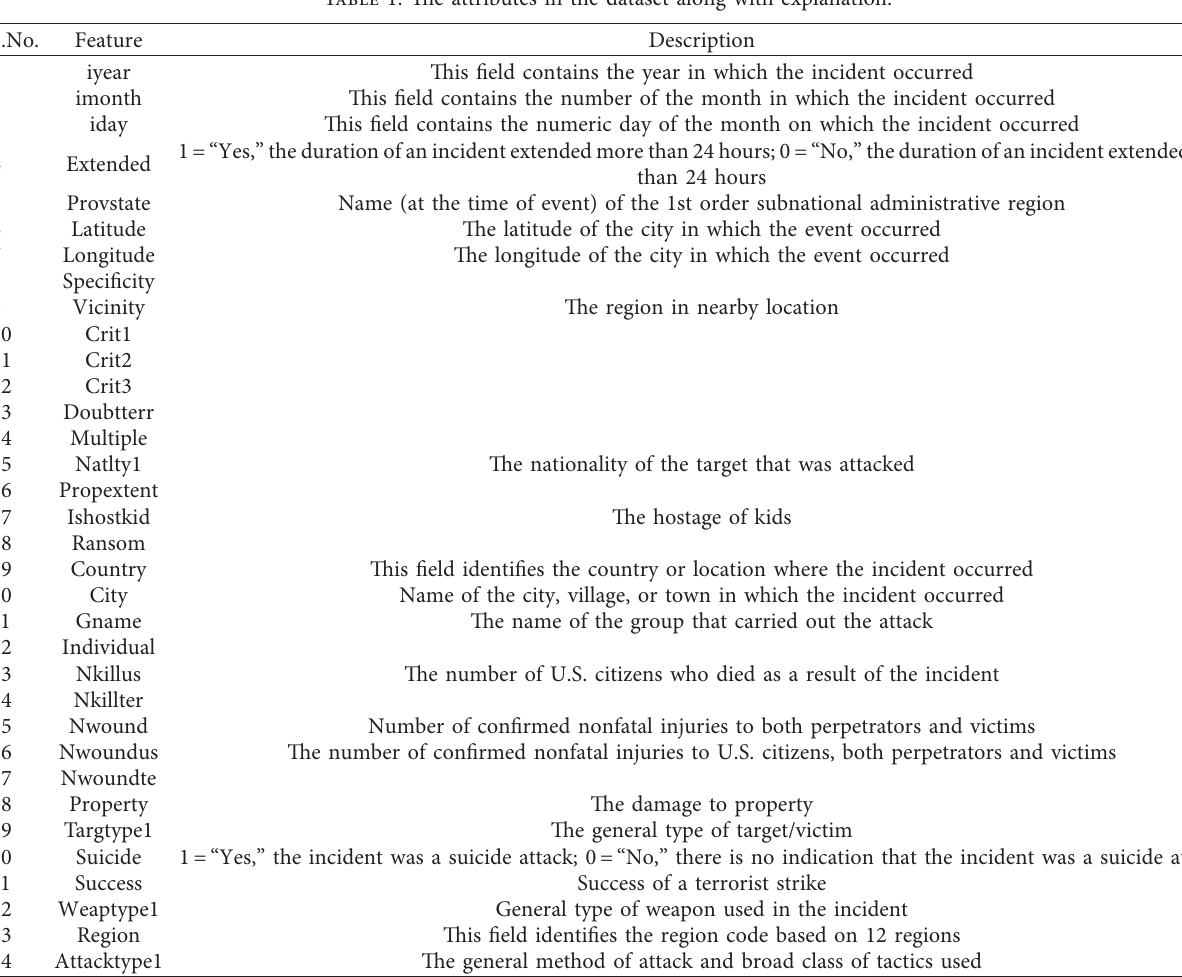
Table 1: The attributes in the dataset along with